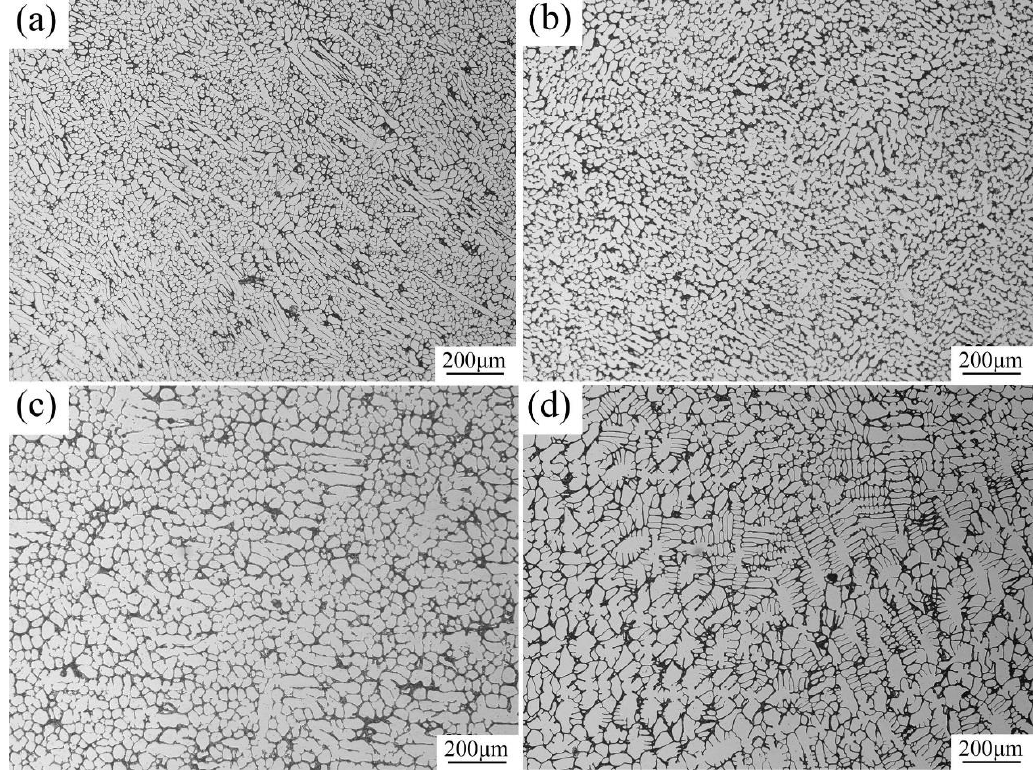
Figure 6. Effect of isothermal treatment time at 1400 °C on the microstructure of Ni-Cr-W superalloy: ( a ) 2 min; ( b ) 5 min; ( c ) 10 min; ( d ) 15 min.